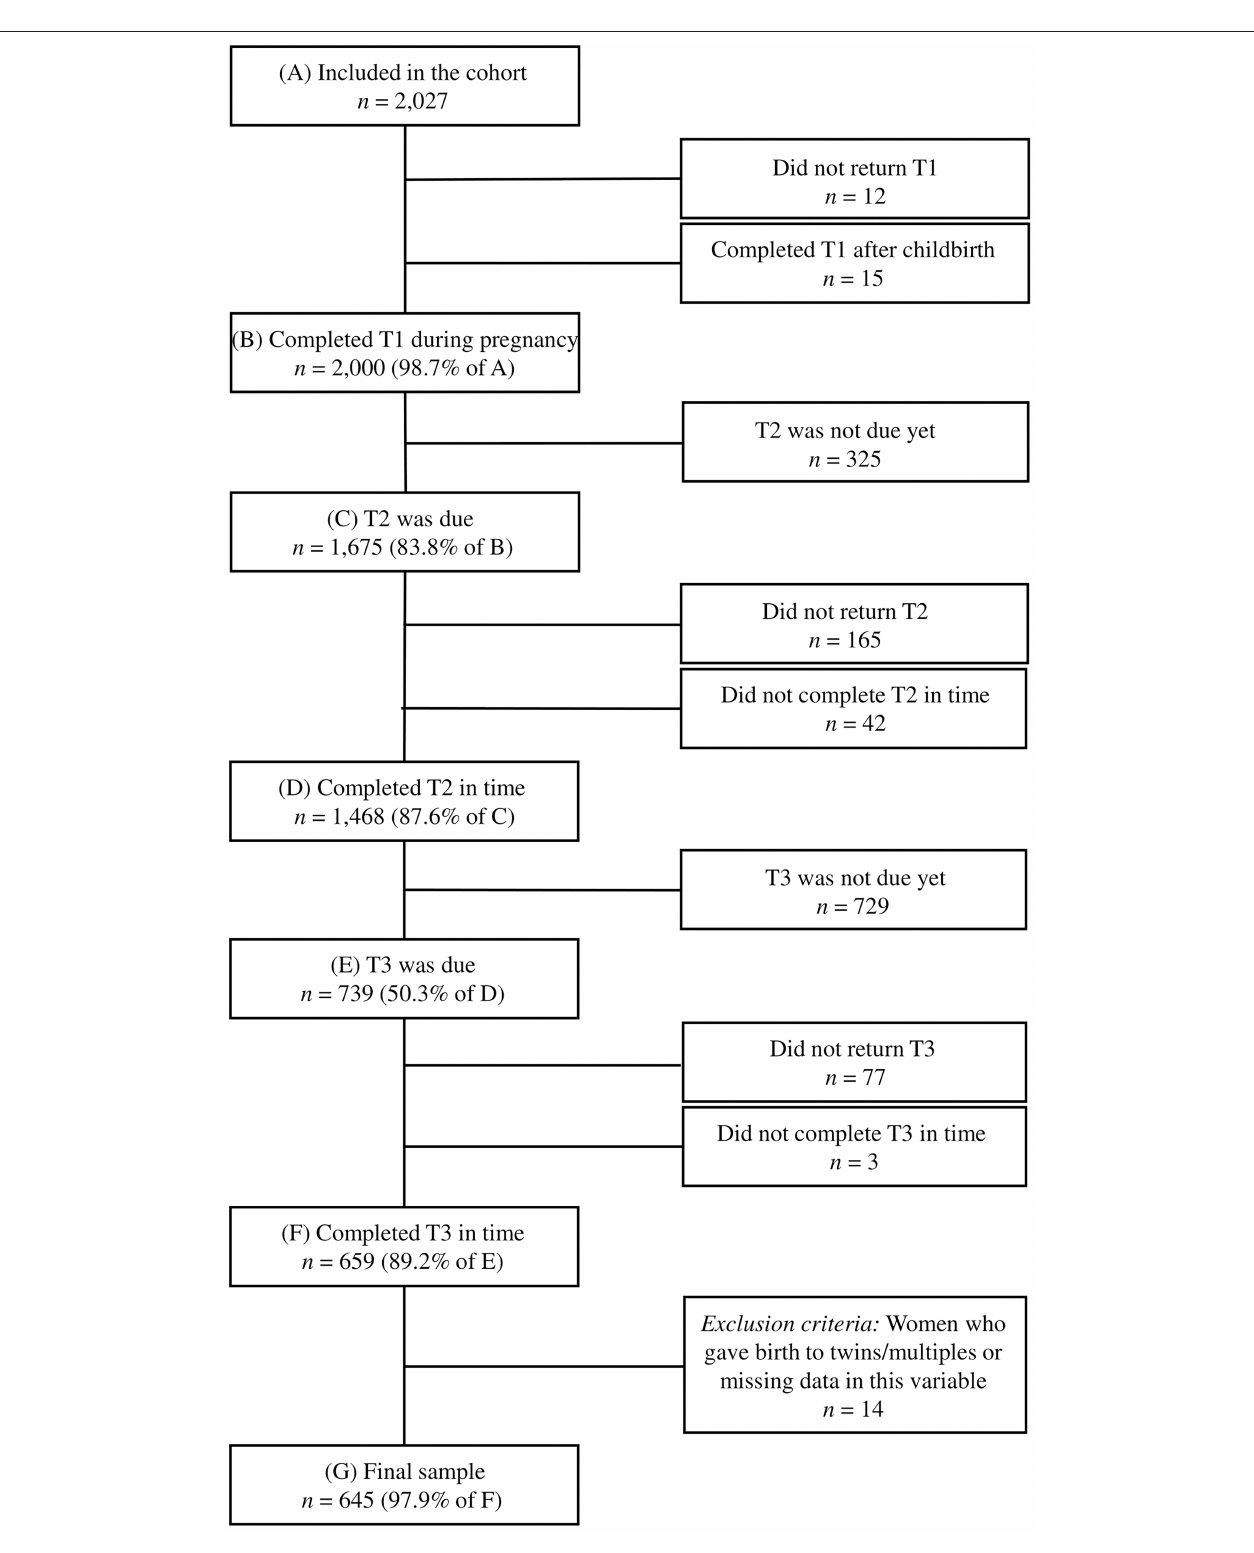
Frontiers in Psychiatry |